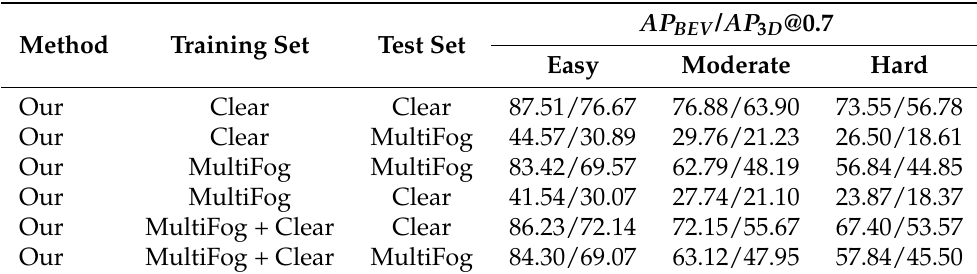
Table 2. AP BEV / AP 3 D results with training and testing on the Clear KITTI or Multifog KITTI datasets for “Car” objects with IoU = 0.7 on three levels of difficulty: Easy, Moderate and Hard.